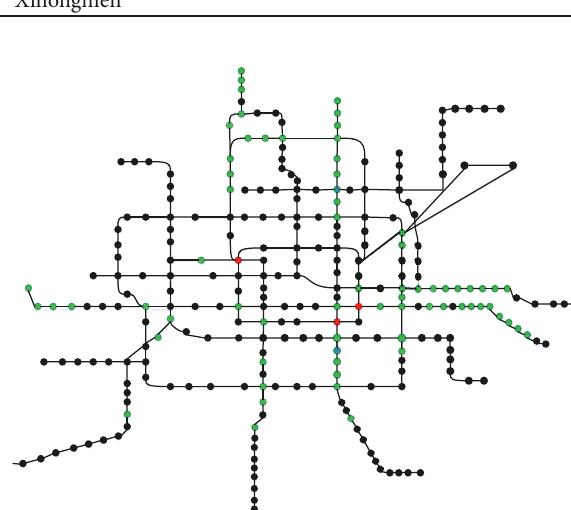
Figure 5: Ratio of driver nodes to nodes of a controllable passenger flow network.